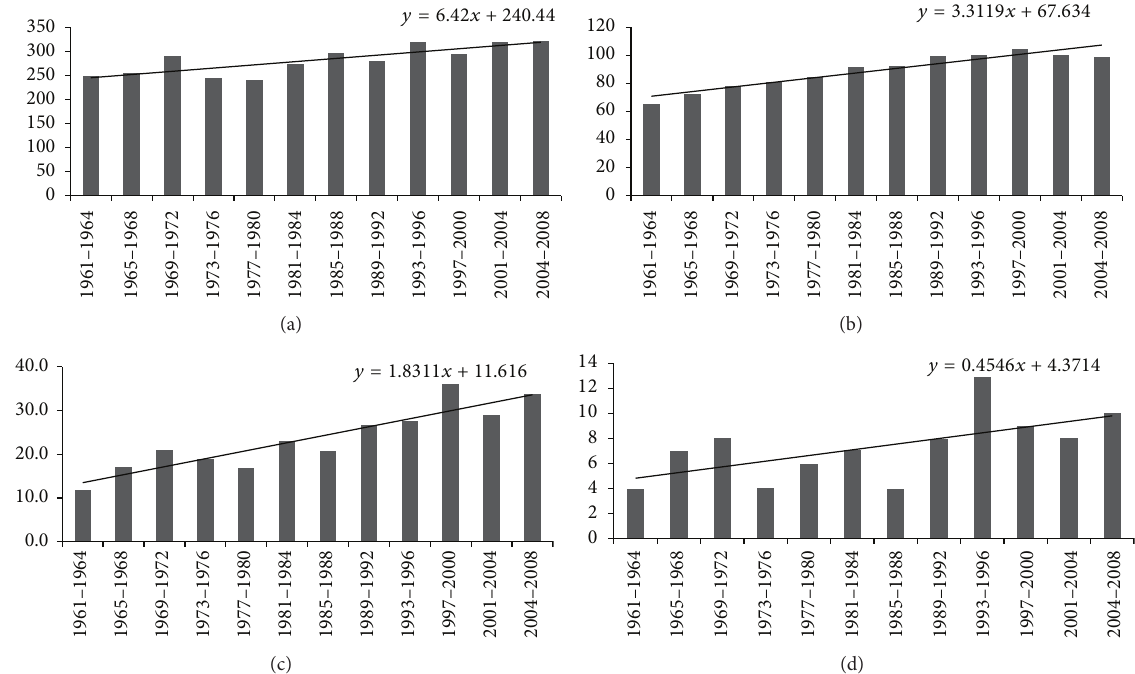
Figure 7: Frequency of occurrence of extreme precipitation events in Xinjiang exceeding 357 thresholds as follows: (a) 10; (b) 20; (c) 30; (d) 40 mm. Trends indicated in panels are 358 cases/year.